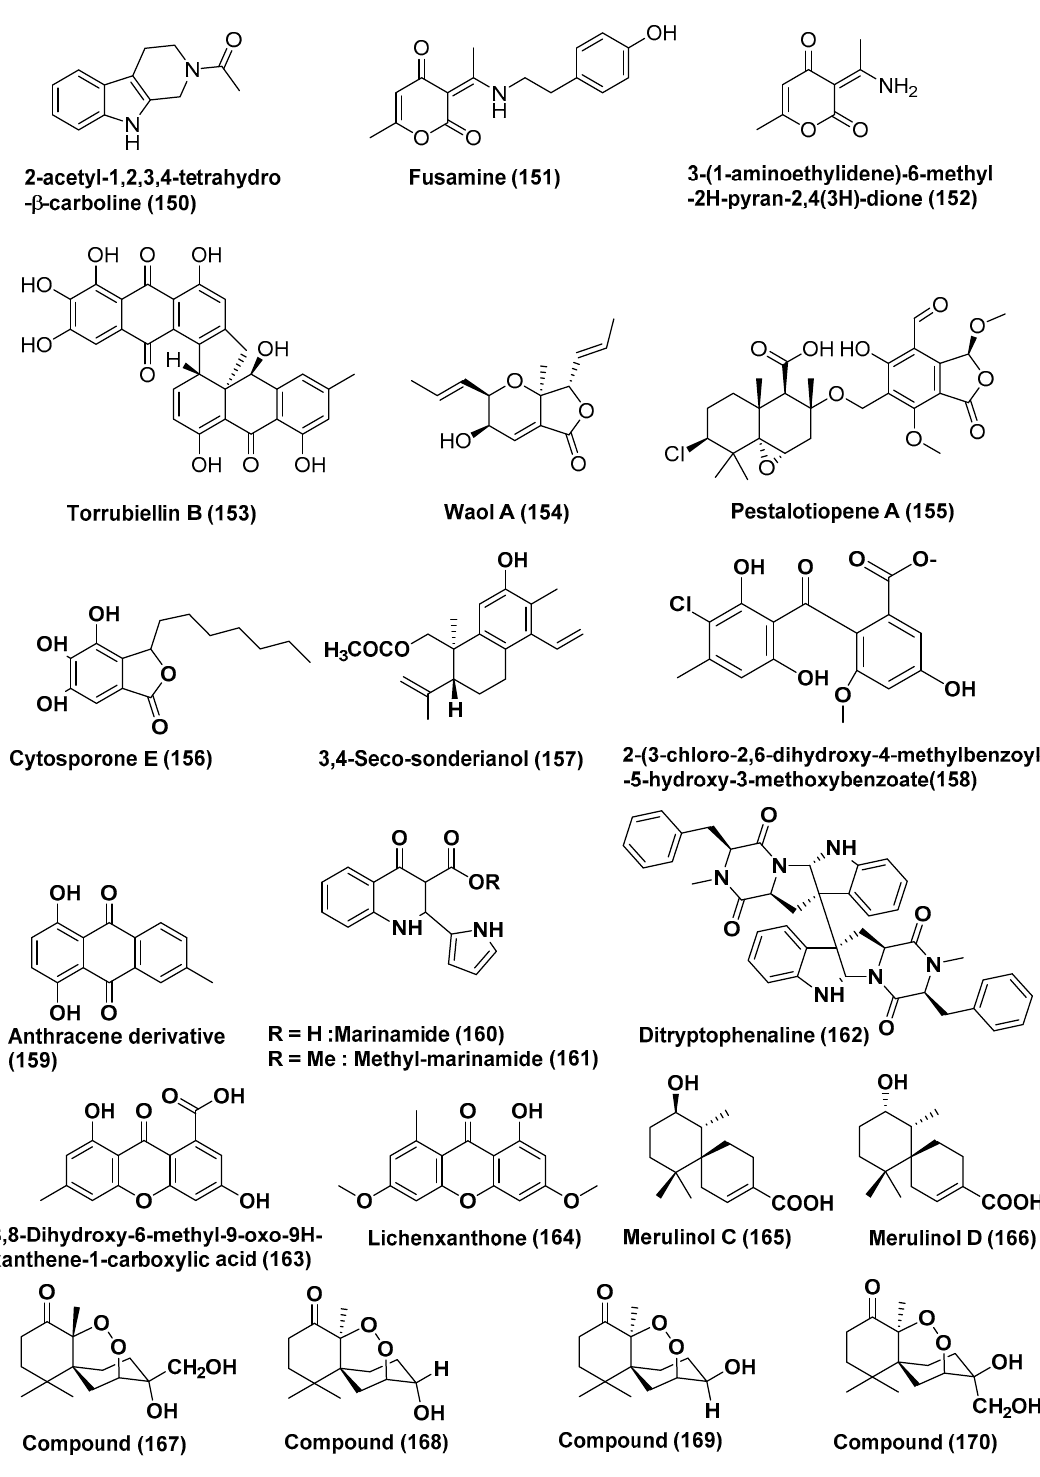
Figure 9. Structures of metabolites isolated from Hyphomycetes ( 150 – 170 ) .